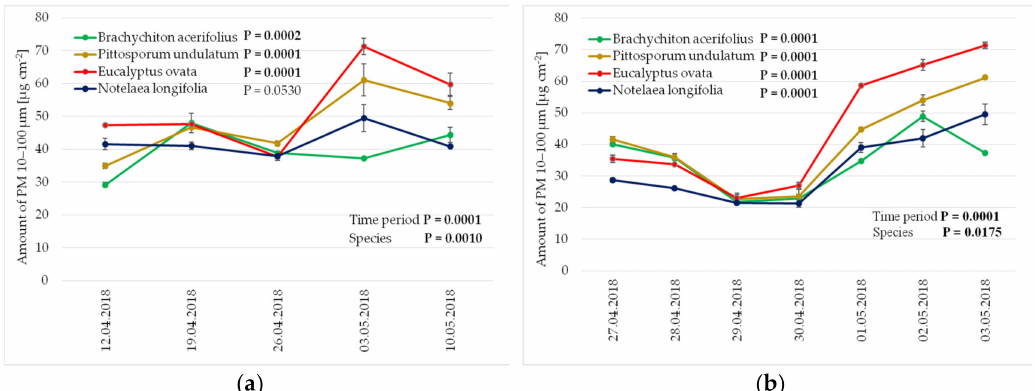
Figure 3. Amount of large PM fraction (10–100 µ m) PM deposited on leaves of B. acerifolius, P. undulatum , E. ovata and N. longifolia during ( a ) five weeks and ( b ) seven days of measurements. Data are means ± SE, n = 3. P values in bold indicate statistical